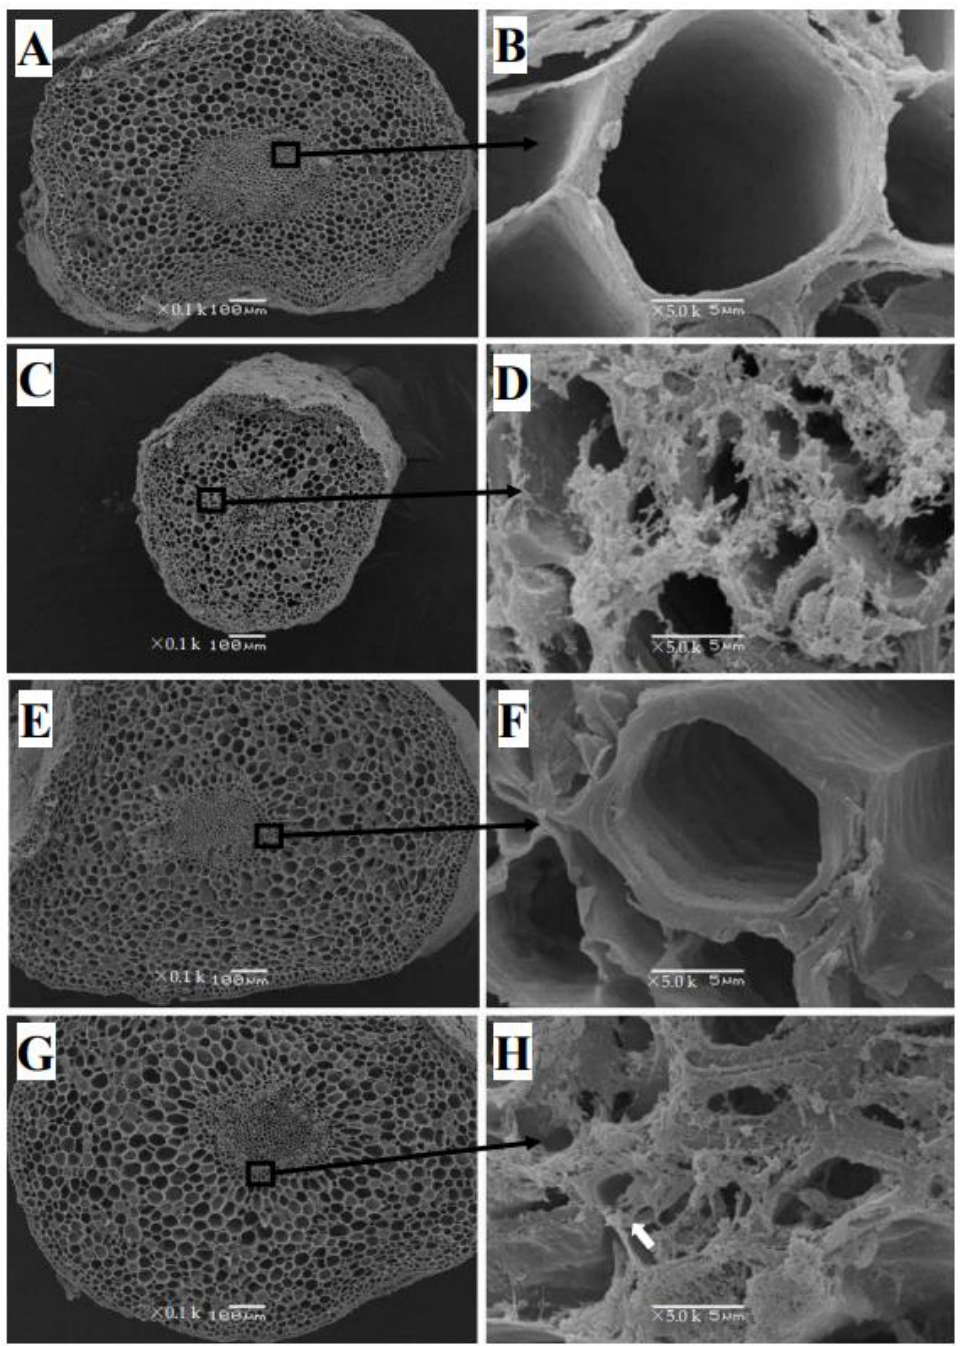
Figure 4. The SEM images of cross-section of 0.5 µM ( A , B , E , F ) and 300 µM Cu-treated ( C , D , G , H ) roots of two citrus species. C. sinensis : ( A – D ); C. grandis : ( E – H ). The right figures are partial enlargements of the left figures. Images ( A , C , E , G ) show epidermis, exodermis, cortex, endodermis, pericycle, xylem and phloem. Images ( B , D , F , H ) show the xylem of the roots. The arrows represent the blocked xylem of roots by flocculent precipitate in ( D ) and ( H ). The scales in figures ( A , C , E , G ) represent 100 μm. The scales in figures ( B , D , F , H ) represent 5 μm.